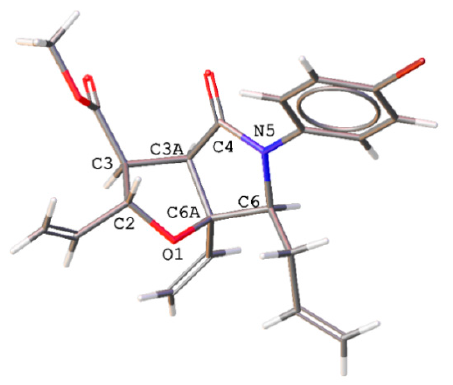
Figure 6. X-ray crystal structure of methyl (2 RS ,3 SR ,3a RS ,6 SR ,6a SR